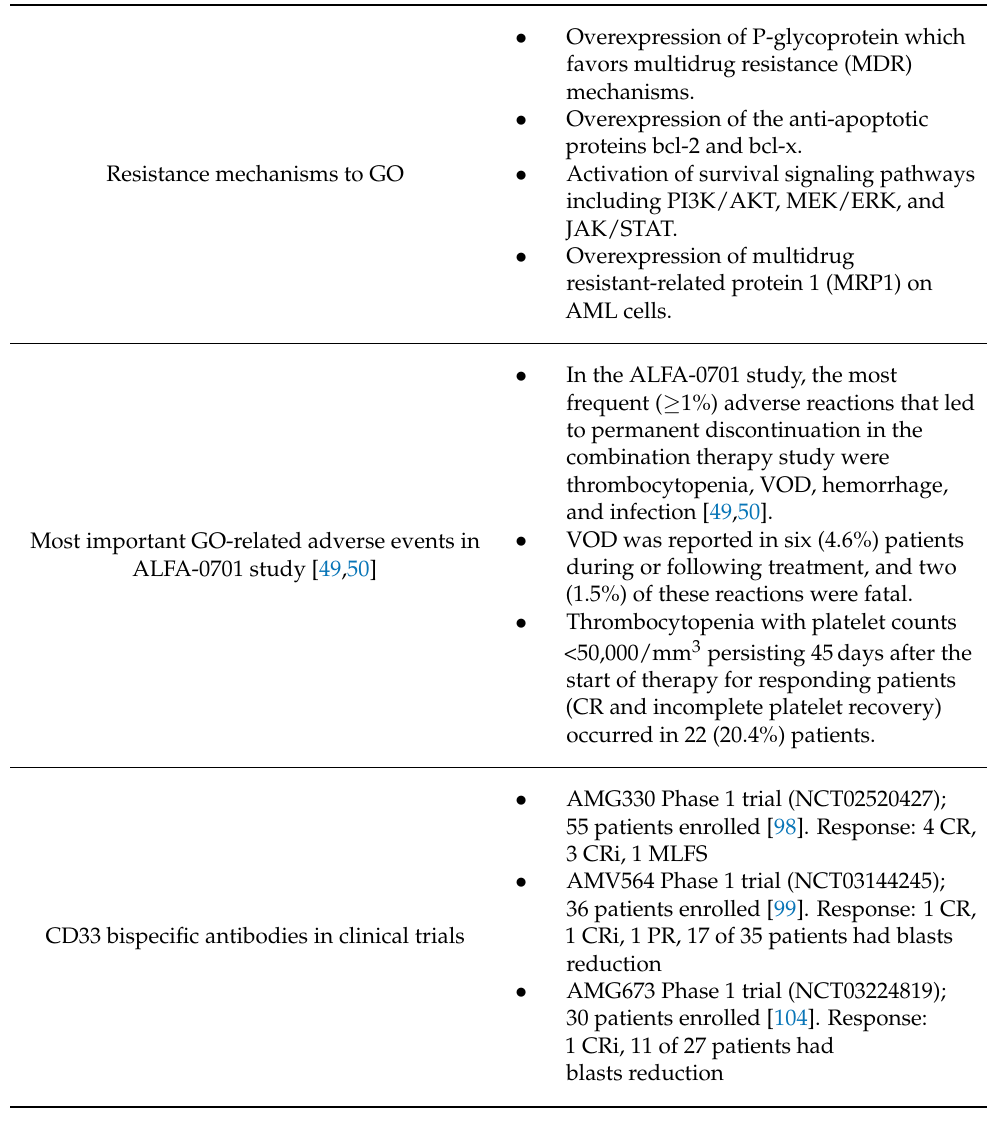
Table 3. The most important resistance mechanisms to GO, GO related adverse events in ALFA-0701 trial, and clinical trials with CD33 bispecific